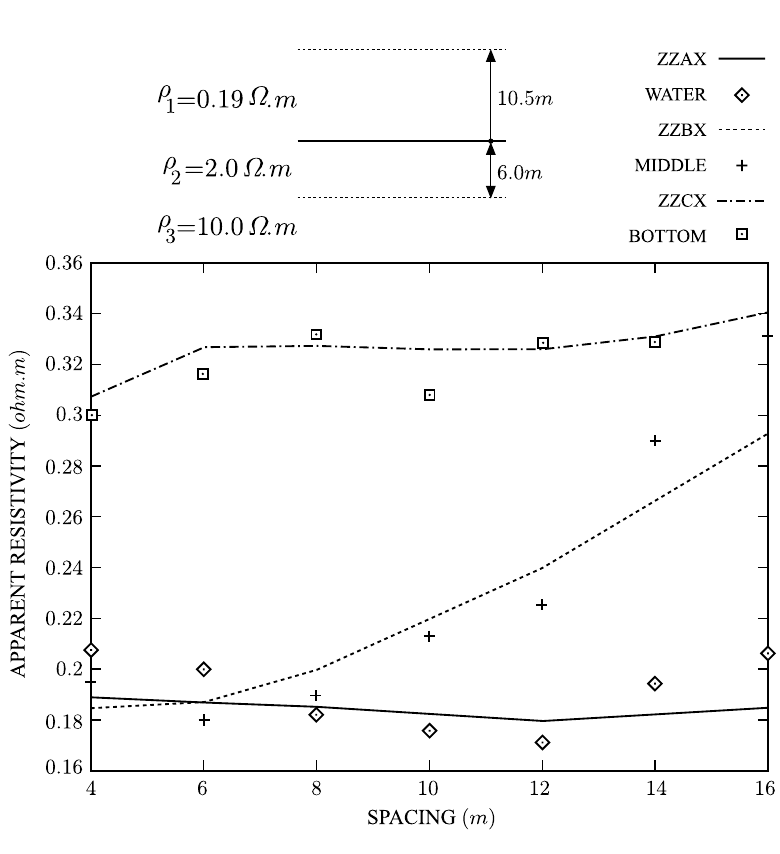
Fig. 8 – Forward modeling of the apparent resistivity for the three sea levels of investigation. ZZAX and WATER represent respectively the theoretical and the experimental data at the sea surface. ZZBX and MIDDLE represent respectively the theoretical and the experimental data at seven meters deep. ZZCX and BOTTOM represent respectively the theoretical and the experimental data at the sea bottom. The experimental data are for f= 0.25 Hz, and the disk electrode with radius of 0.075